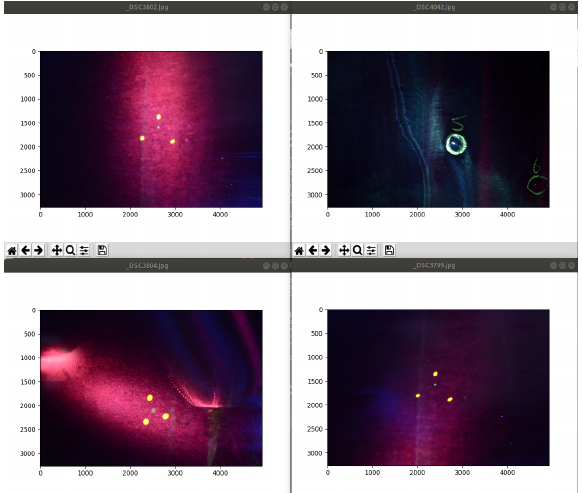
Figure 10. Images identified with defect using the combined SSIM and Histogram comparison method.